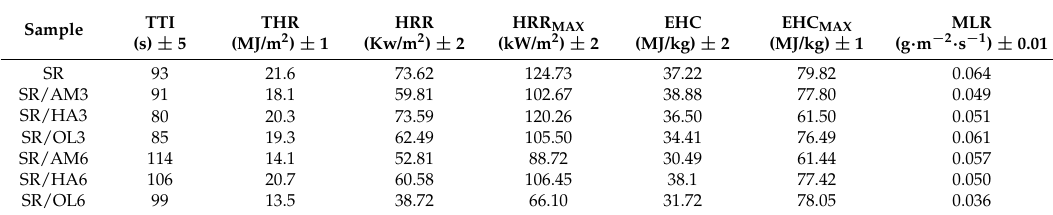
Table 6. Flammability of SR/POSS composites.